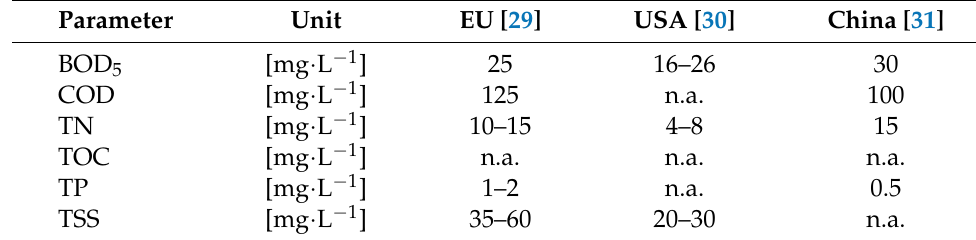
Table 4. Limits for wastewater